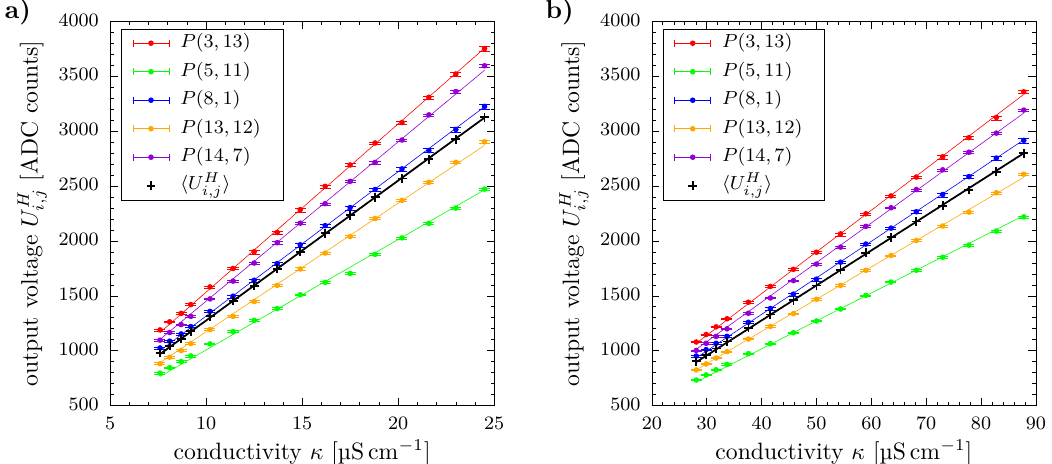
Figure 3. Relation of WMS output voltage and electrical conductivity of ( a ) deionized water and ( b ) water mixture for individual pixels P ( i , j ) (color) and cross-sectional average (black). Straight lines represent regression according to Equation (15).